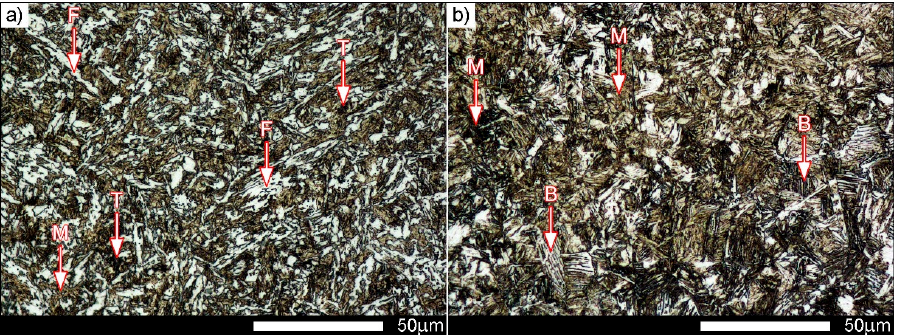
Figure 9. Microstructures of the Hardox 600 joint within weld metal zone—WM2 in Figure 3: ( a ) after welding; and ( b ) after welding and heat treatment. B—bainite, F—ferrite, M—martensite, T—troostite. Light microscopy, etched with 2% HNO 3 .